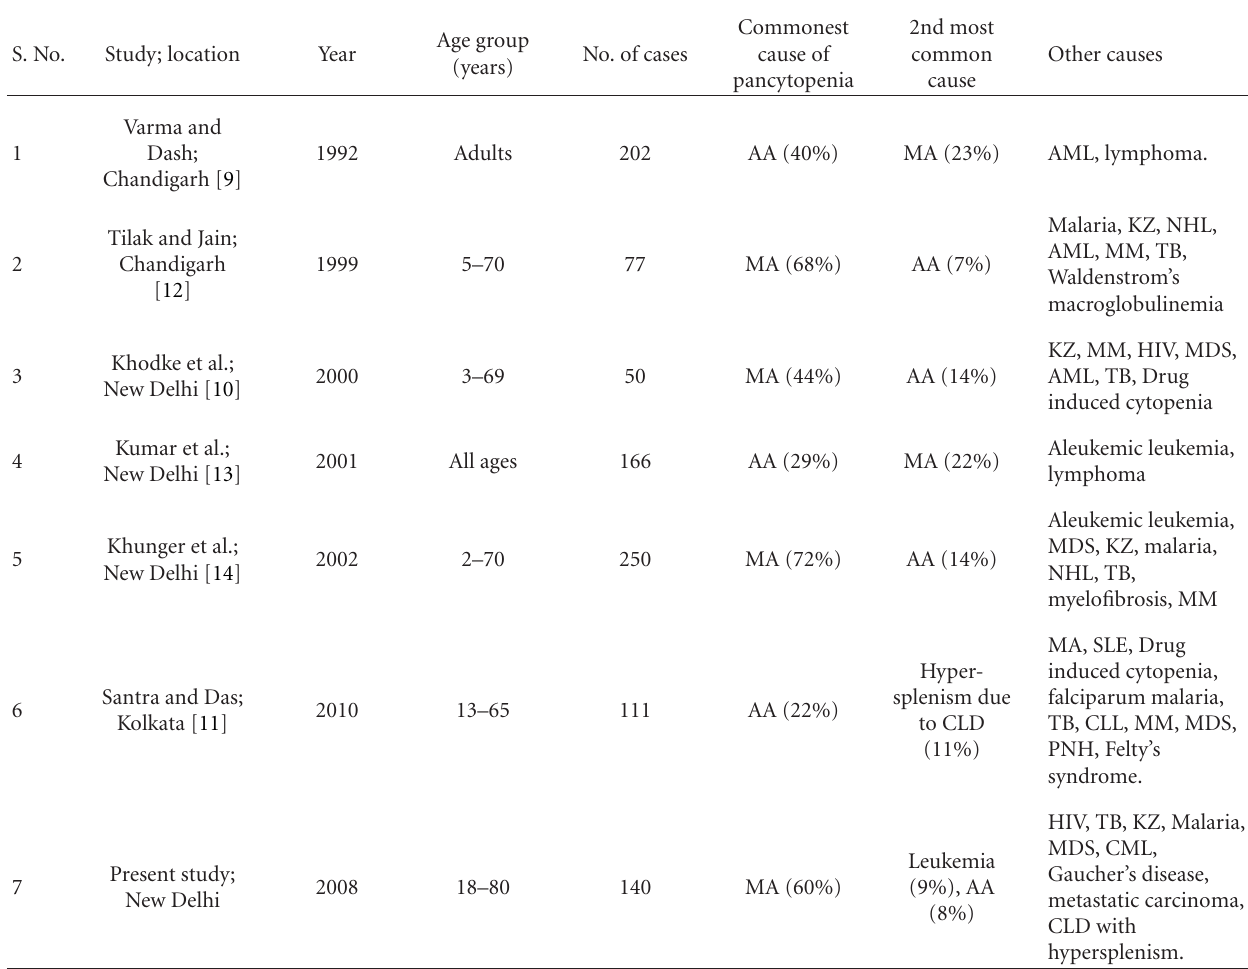
Table 5: Indian studies on